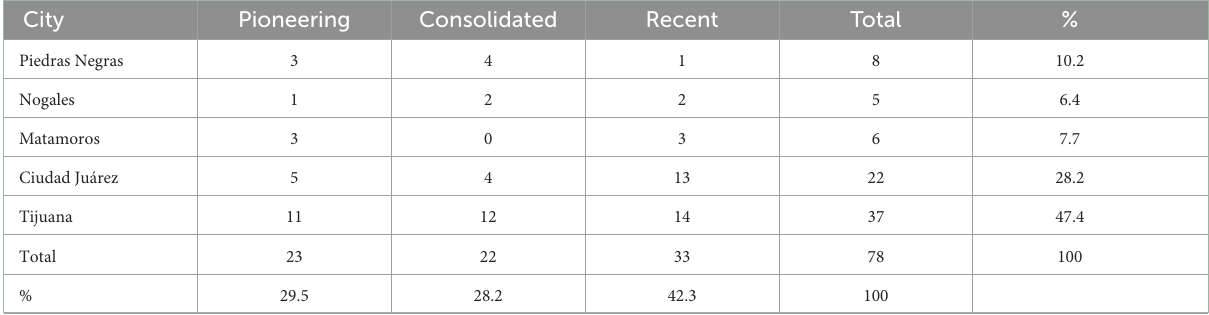
TABLE 1 Pioneering, consolidated, and recent shelters in the cities under study July–December 2020.